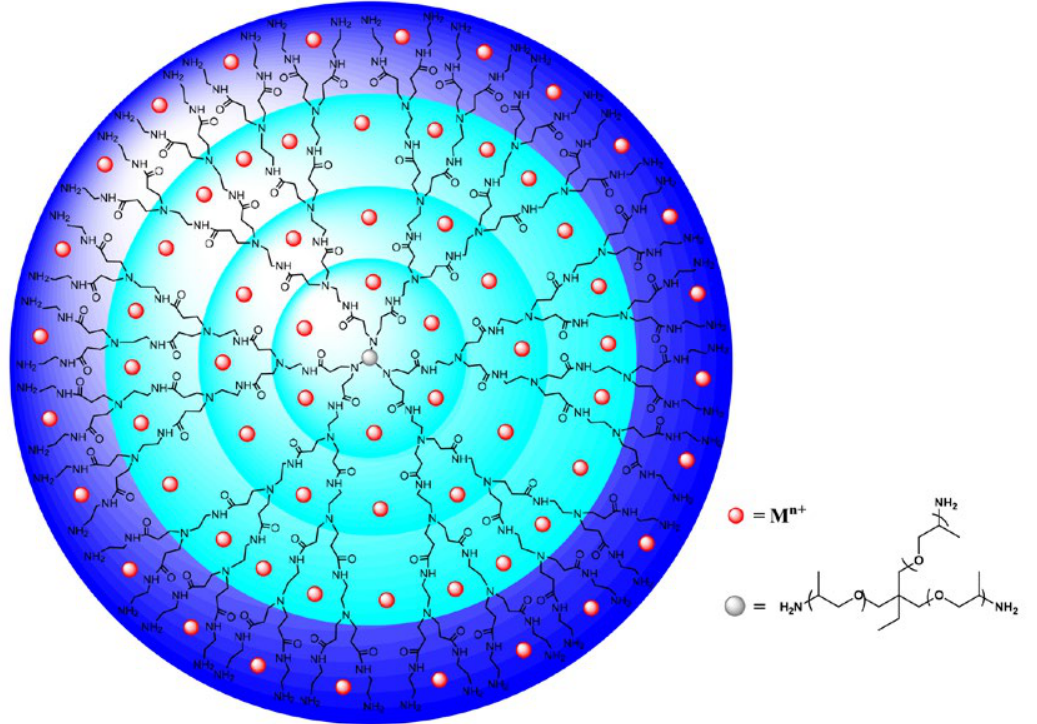
Figure 1. Representative chemical structure of G3-NH